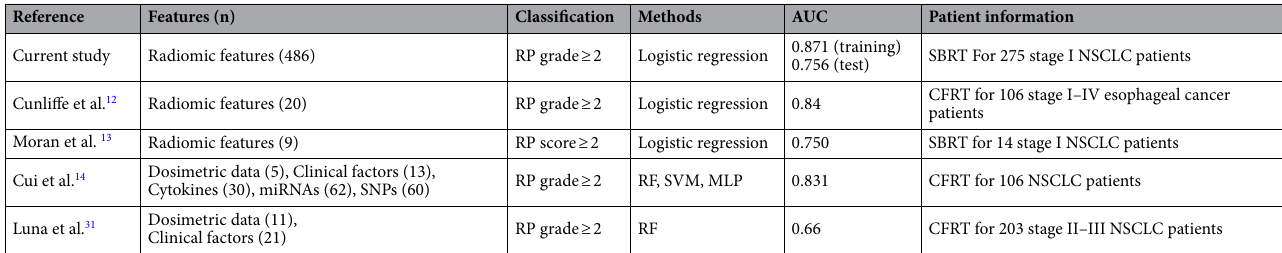
Table 4. AUCs for different studies using different RP prediction strategies. miRNAs, micro RNAs; SNPs, single nucleotide polymorphisms; RF, random forest; SVM, support vector machine; MLP, multilayer perceptron; CFRT, conventional fractionated radiotherapy. RP grades were decided according to the Common Terminology Criteria for Adverse Events. RP scores were assigned based on identification of radiographic changes between pre- and post-RT CT